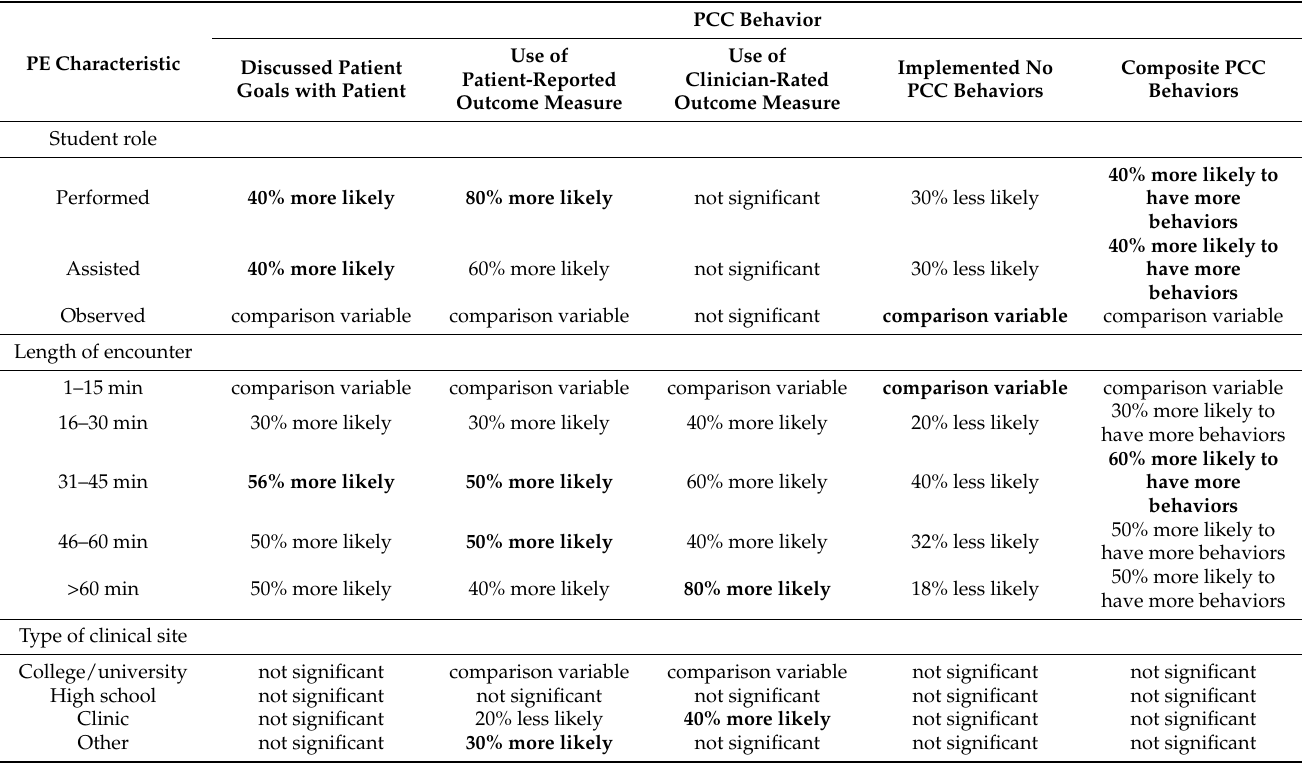
Table 2. Clinical associations of patient-centered care (PCC) behaviors implemented by athletic training students during patient encounters (PE) 1